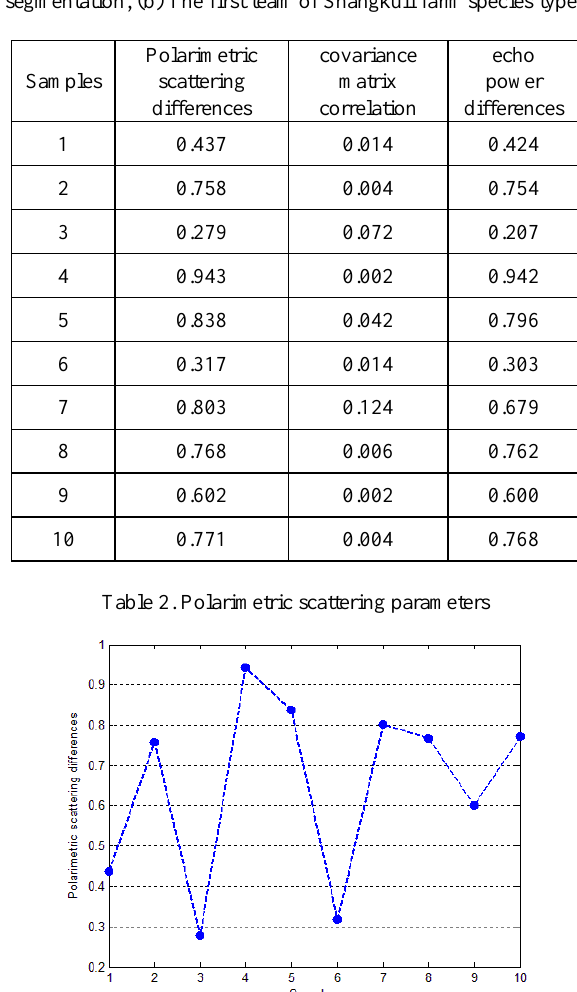
Figure 6. The samples distribution, (a) The image after segmentation, (b) The first team of Shangkuli farm species type